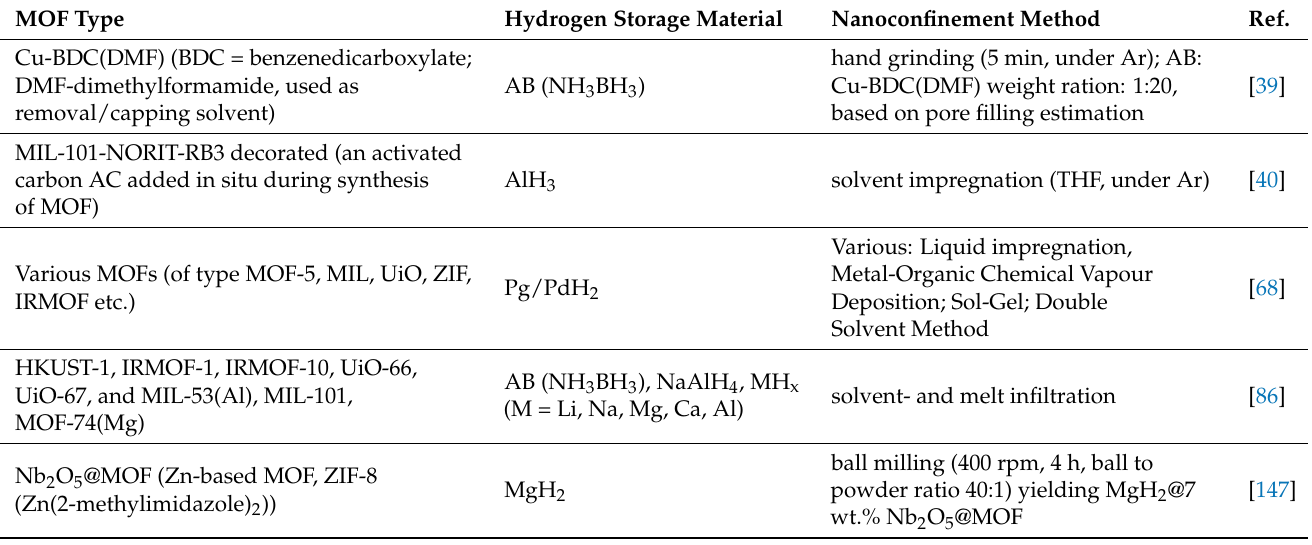
Table 3. Recent progress in MOF-based nanoconfined hydrogen storage